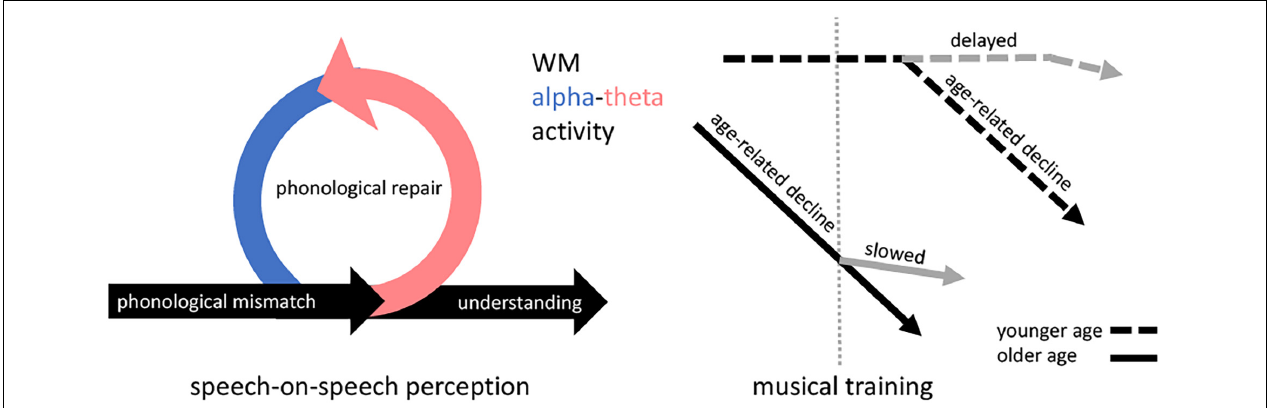
FIGURE 1 | Hypothesized framework. Left, During speech-on-speech perception, the Ease of Language Understanding model (ELU; Rönnberg et al., 2019) describes how mismatch in phonological binding can occur which in turn triggers an explicit processing loop to repair the mismatch. The repair loop is governed by WM, consisting of the subcomponents pre-diction (blue) and post-diction (pink). Post-diction explicitly reevaluates lexical context, and pre-diction informs the (re-)binding of phonological information from the target speech signal in part by inhibiting distractor speech. Here, we suggest that the pre-diction and post-diction subcomponents of the loop are underpinned by alpha- and theta oscillatory activity, respectively. Right, We hypothesize further that any age-related decline in WM-related alpha-theta activity can be delayed if musical training occurred in younger age, or slowed by musical training in older age. In turn, musical training may preserve speech-on-speech perception longer into older age because preserved alpha-theta activity ensures proper repair of mismatched phonological binding. WM = working